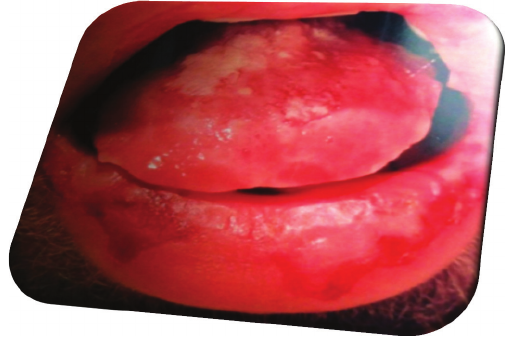
F 1: Swollen crusted lips.